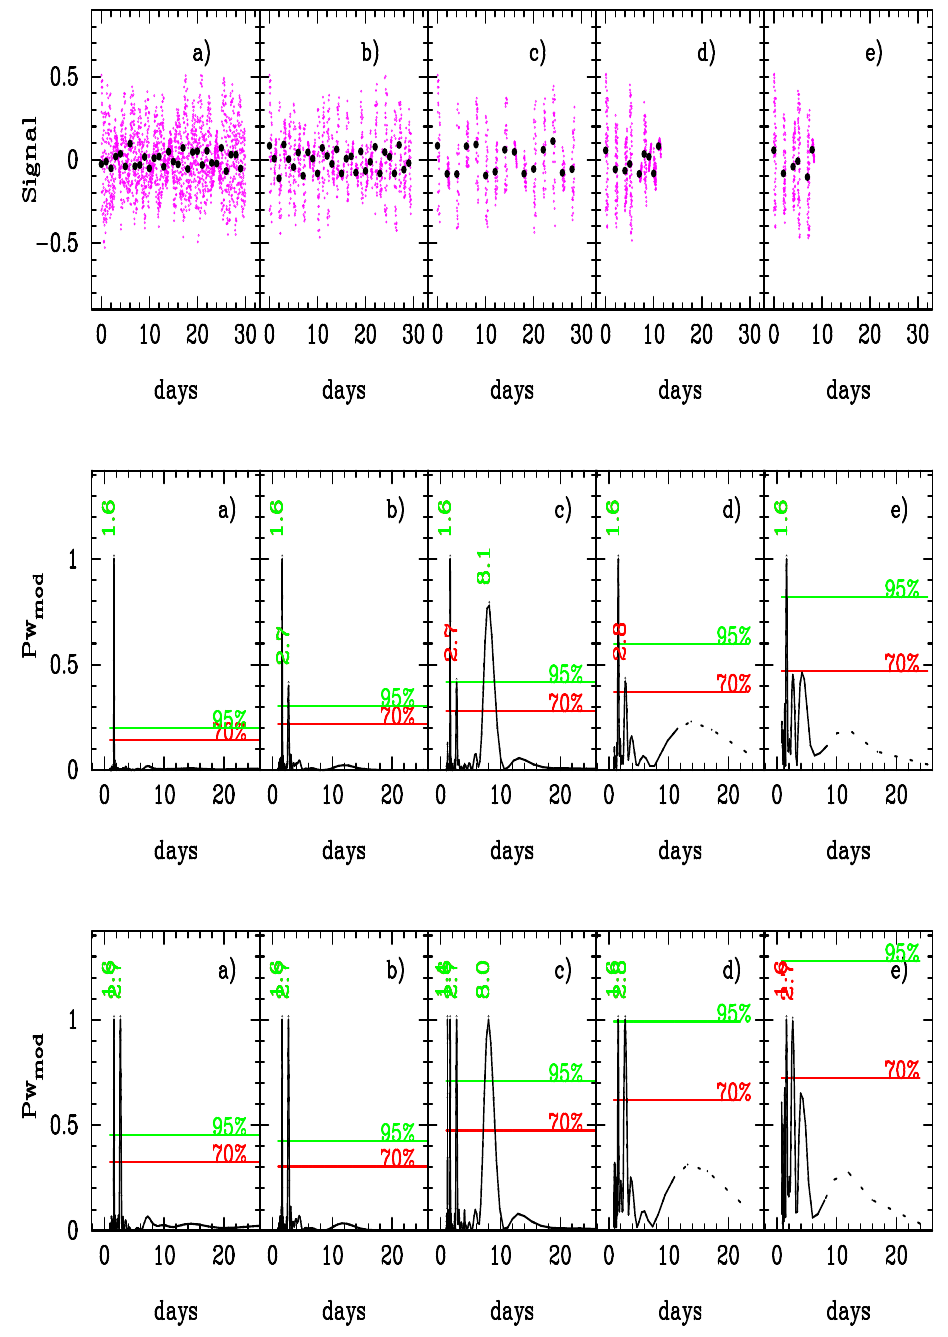
Fig. A2. Upper panel: Simulations of a periodic signal of 1.6 days of period plus noise. Points: data at a rate of 3 data per hours. Solid circle: Averaged nightly data. Simulations: (a) , (b) , (c) , (d) and (e) as in Fig. A1. Middle panel: Periodograms of all data time series. Lower panel: Periodograms of nightly averaged data time